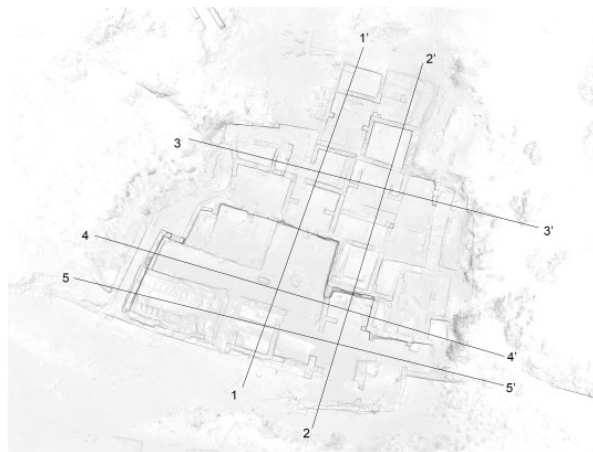
Figure 14. Planimetric schema of cross-section.